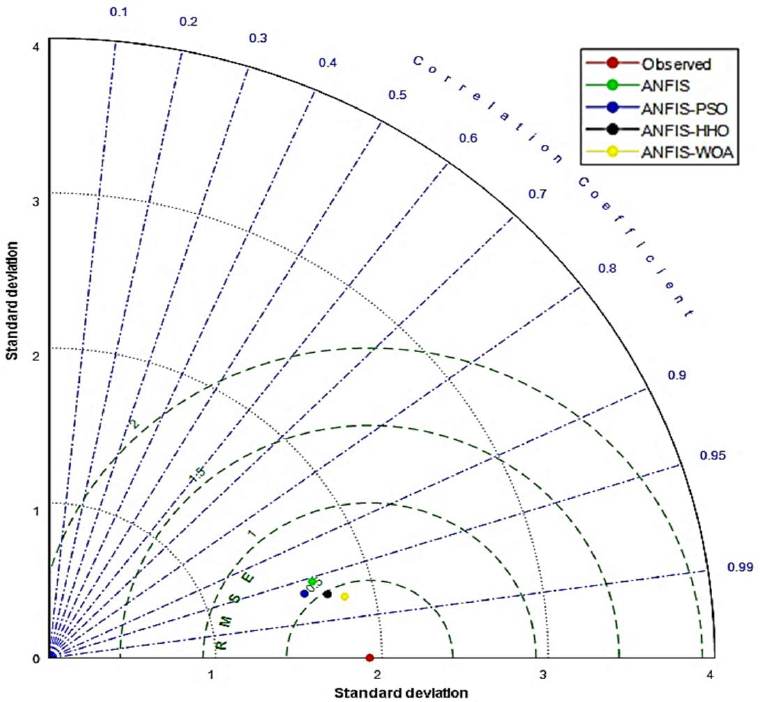
Figure 6. Taylor diagram of the predicted Epan using the hybridized ANFIS models in the testing phase using the best input combination — Nanxian Station.